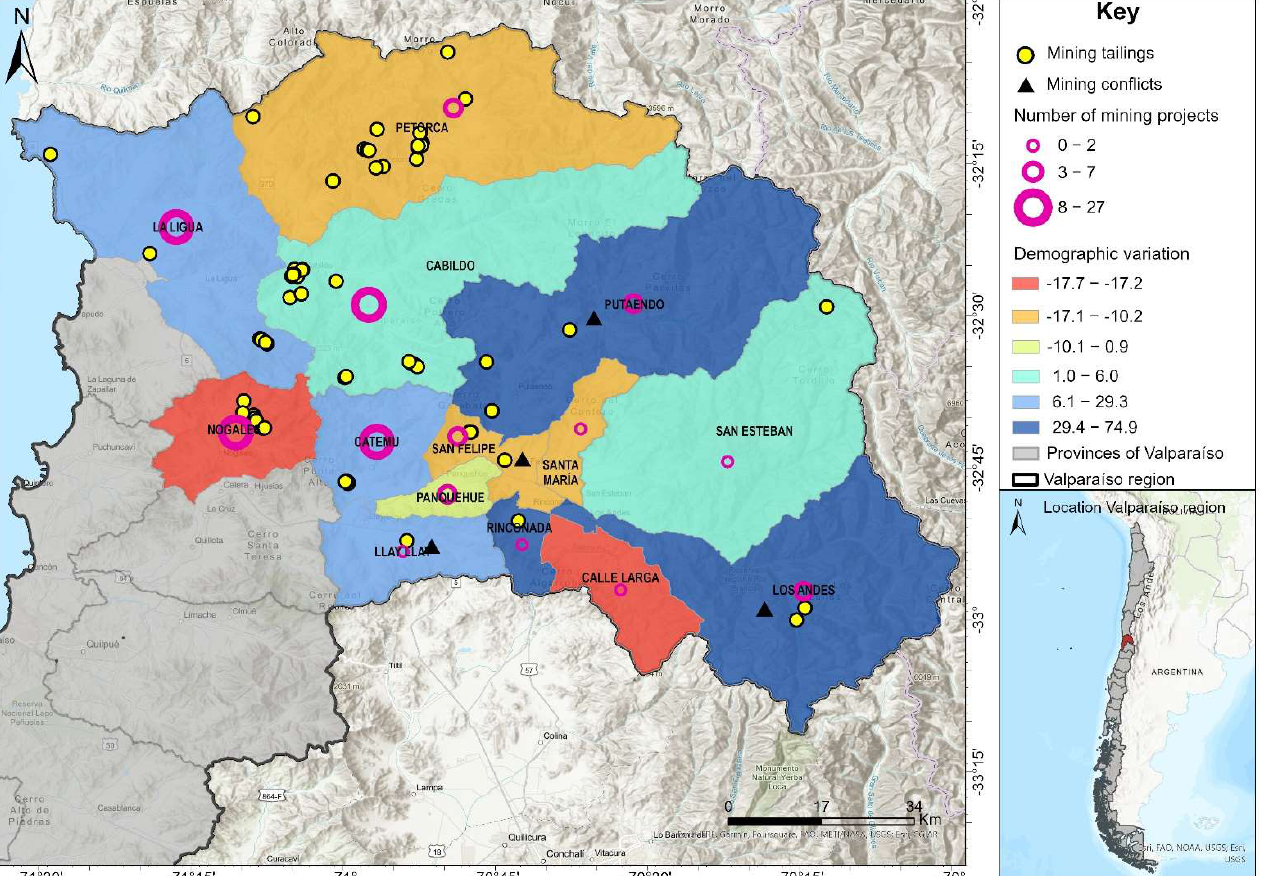
Figure 3. Rural depopulation, mining activities, mine tailings, and mining conflicts.